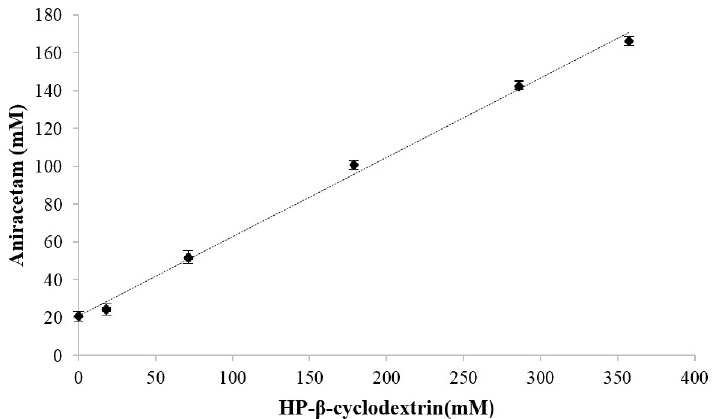
Figure 1. Phase solubility profile of aniracetam as a function of HP-β-CD concentration in water at 30 °C. y = 0.4192 x + 20.727, R ² = 0.9953. Each data point represents mean ± S.D, n = 3.